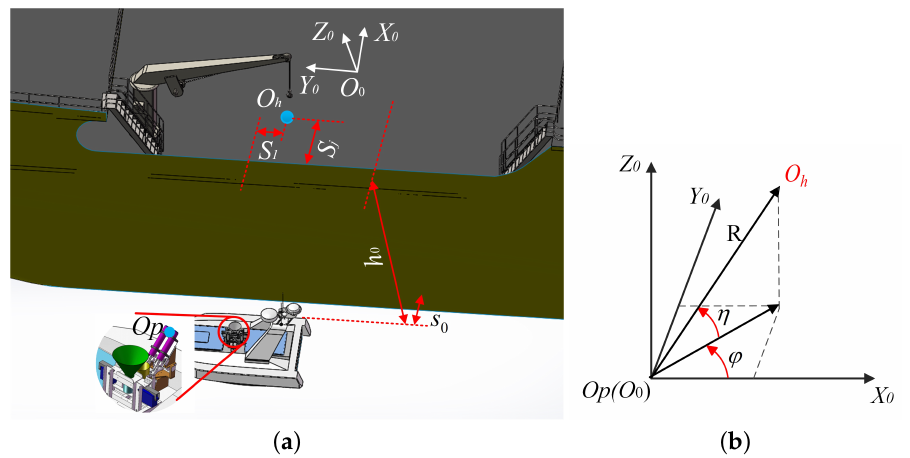
Figure 3. Coordinate systems. ( a ) Overview. ( b ) The azimuth angle ϕ and the elevation angle η in the world coordinate